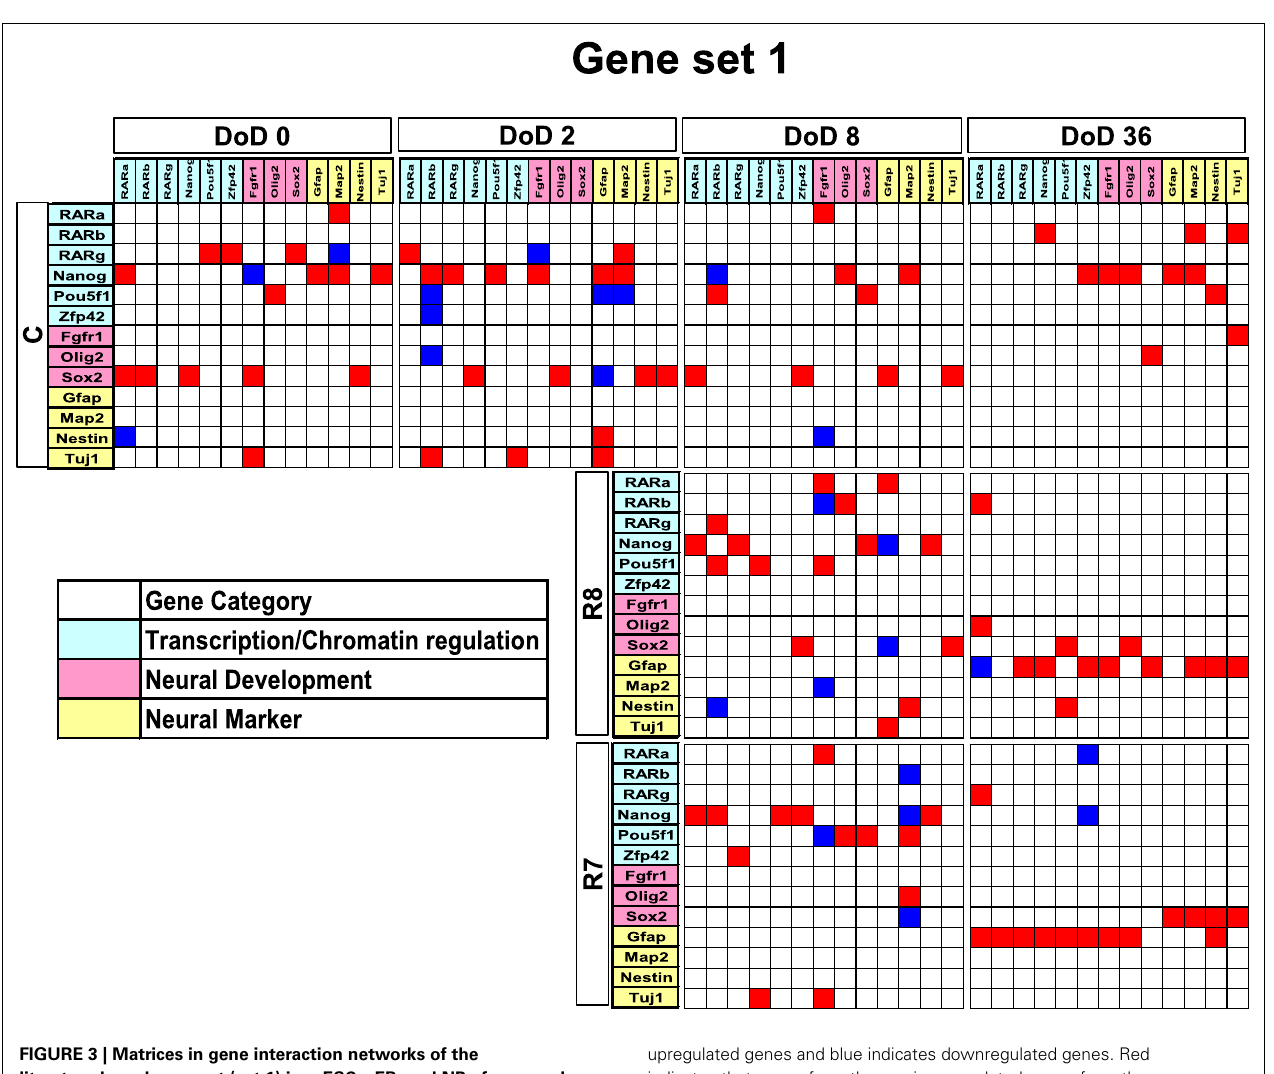
FIGURE 3 | Matrices in gene interaction networks of the literature-based gene set (set 1) in mESCs, EB, and NP of neuronal differentiation. Gene Symbols, RARa , RARb , RARg , Nanog , Pou5f1 , Zfp42 , Fgfr1 , Olig2 , Sox2 , Gfap , Map2 , Nestin , Tuj1 , line up in order of up to down in the y axis and left to right in the x axis. Red indicates